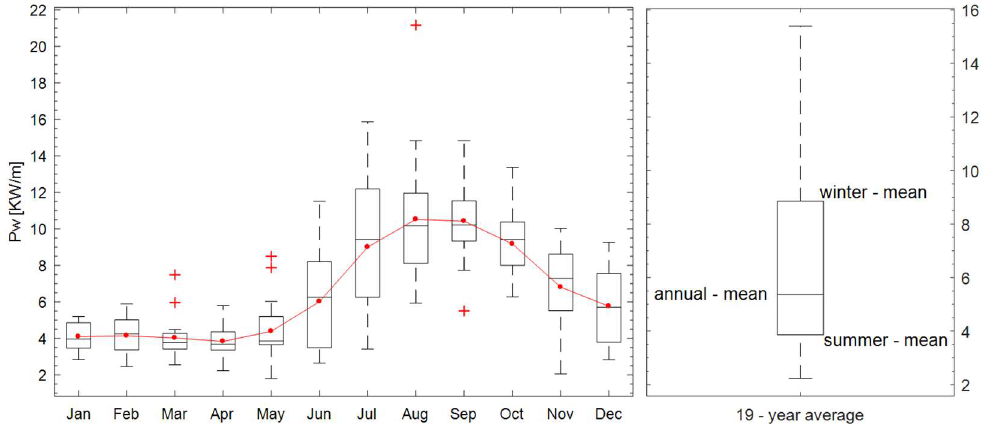
Figure 8. The seasonal variability of P w in Kilifi. The red line represents monthly mean values of P w , the box plot contains the median-middle mark, the 25th and 75th percentiles—the bottom and top edges of the box, respectively. The red crosses are outliers of P w , representing for example storms and tropical cyclones.